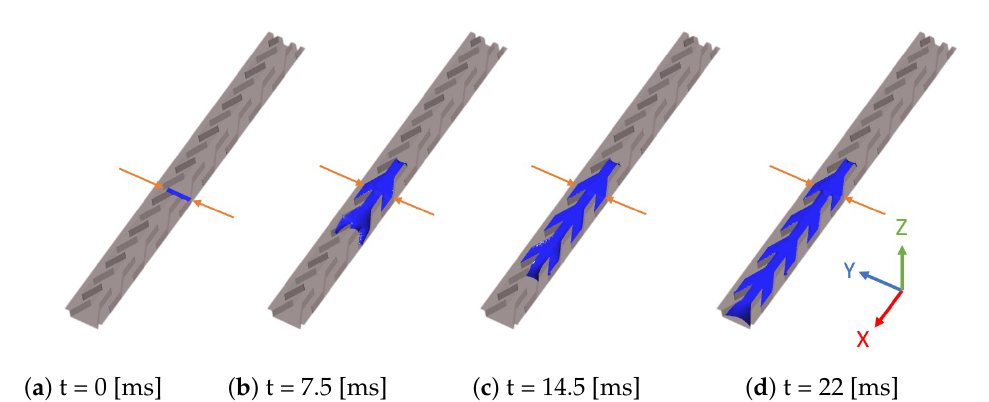
Figure 17. VOF simulation with an inlet at the bottom of channel A. Inlet flux is 1.06 mm 3 /s and